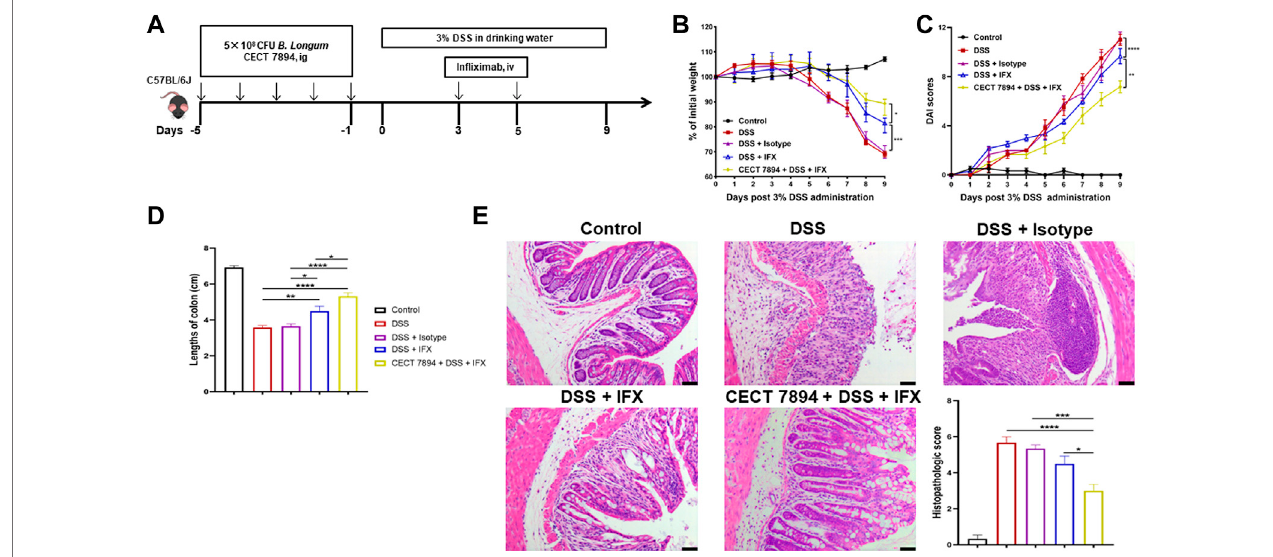
FIGURE 1 | B. longum CECT7894 improves the ef fi cacy of IFX for DSS-induced colitis in mice. (A) Diagram illustrating the mouse model of colitis employed in this study. (B) Body weight changes. (C) The disease activity index (DAI) assessment. (D) Colon length at day 9. (E) H&E staining analysis and histology score. Scale bar represents 25 µm in each image. Data were presented as mean ± SEM ( n = 6 per group). Statistical signi fi cance was assessed by using one-way ANOVA followed by Tukey ’ s test. * p ≤ 0.05, ** p ≤ 0.01, *** p ≤ 0.001, **** p ≤ 0.0001.